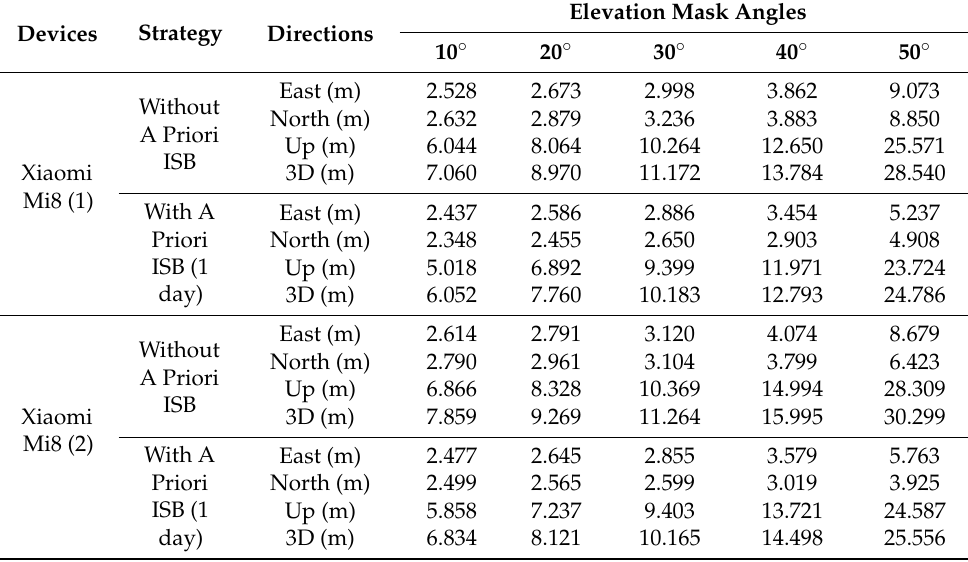
Table 8. Positioning accuracy in (m) of four-system integrated SPP for two smartphones with and without a priori ISB constraints under different elevation masks.